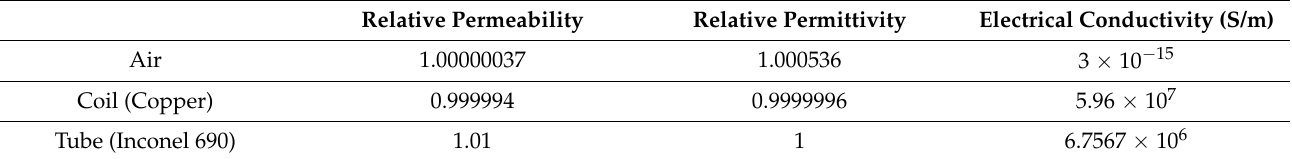
Table 1. The material properties used in the